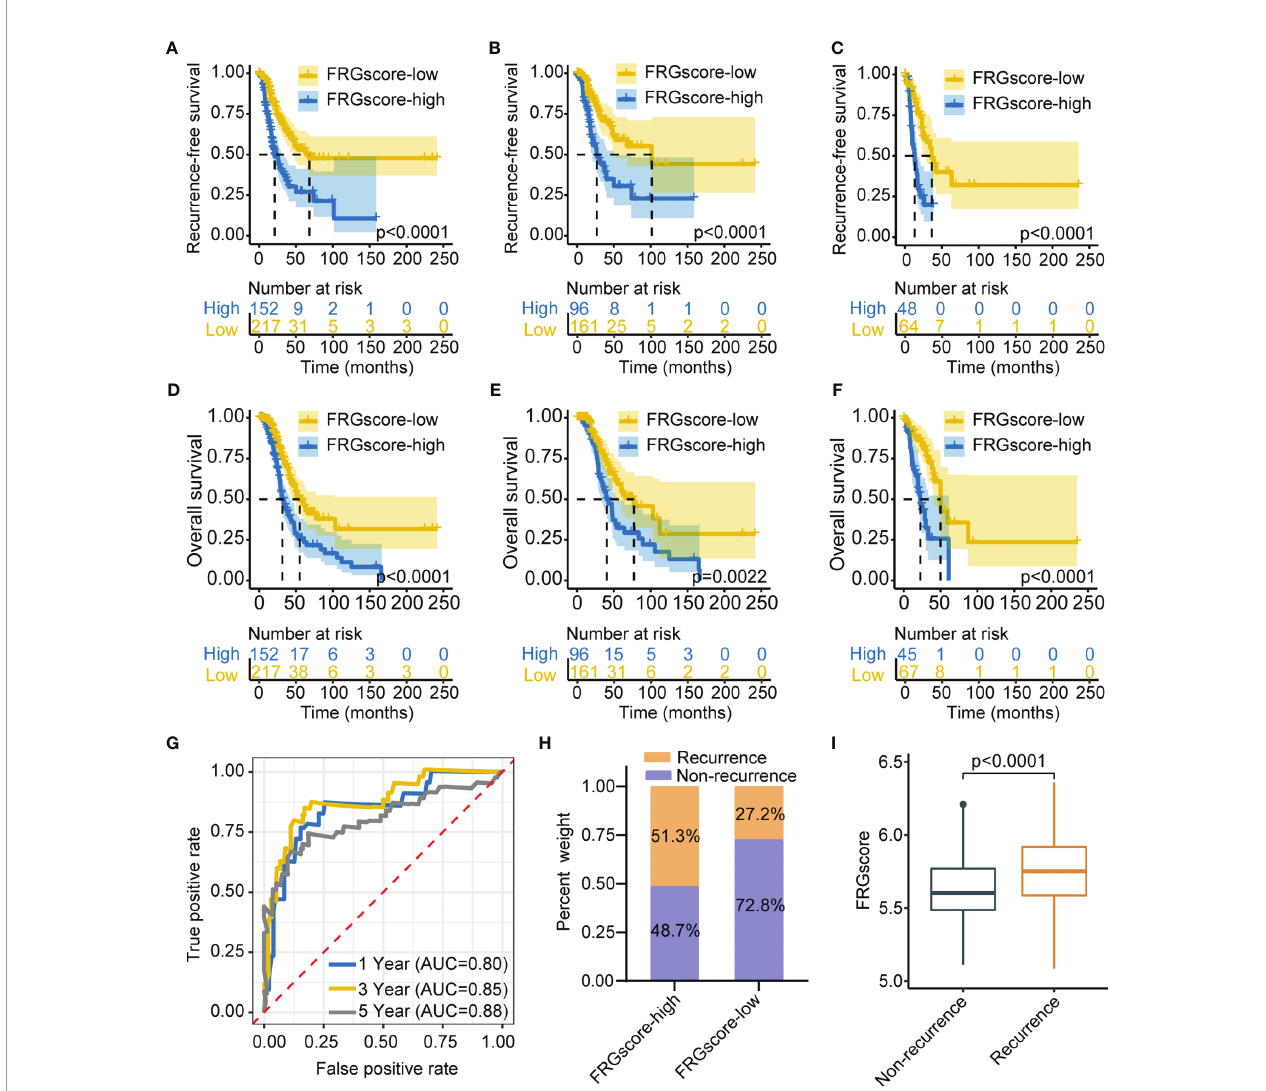
FIGURE 2 | Construction of FRGscore to determine early-stage LUAD recurrence in TCGA cohort. (A) Kaplan – Meier curves showing recurrence-free survival in FRGscore-high and FRGscore-low subgroups. (B, C) Kaplan – Meier curves showing recurrence-free survival in stage I (B) and stage II (C) LUAD patients based on FRGscore. (D) Kaplan – Meier curves showing OS in FRGscore-high and FRGscore-low subgroups. (E, F) Kaplan – Meier curves showing OS in stage I (E) and stage II (F) LUAD based on FRGscore. (G) Time-dependent ROC analysis of FRG signatures for predicting recurrence risk at 1, 3, and 5 years. (H) Proportion of recurrence risk in FRGscore-high or FRGscore-low subgroups. (I) Distribution of FRGscore in recurrence and non-recurrence subgroups. FRGscore, ferroptosis-related gene score; LUAD, lung adenocarcinoma; TCGA, The Cancer Genome Atlas; OS, overall survival; ROC, receiver operating